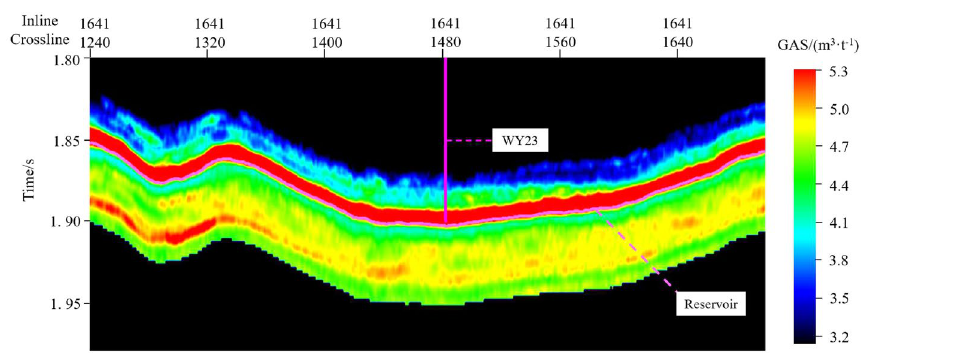
Figure 13. GAS section view of the Longmaxi